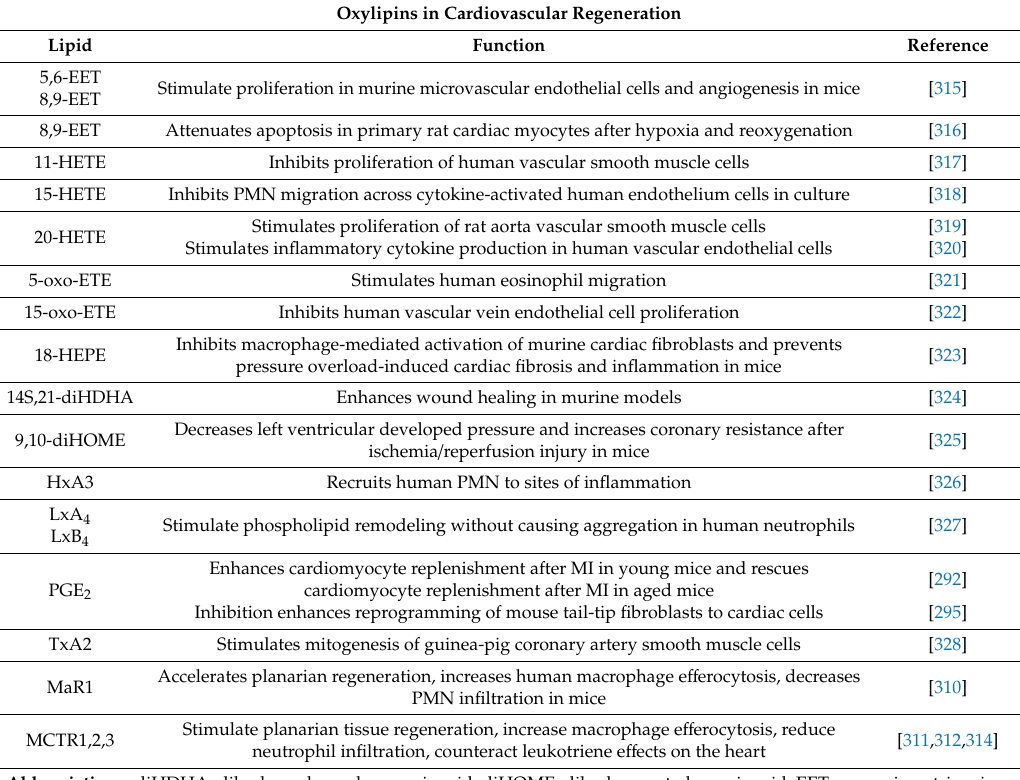
Table 2. Specific oxylipins and their functions in cardiovascular